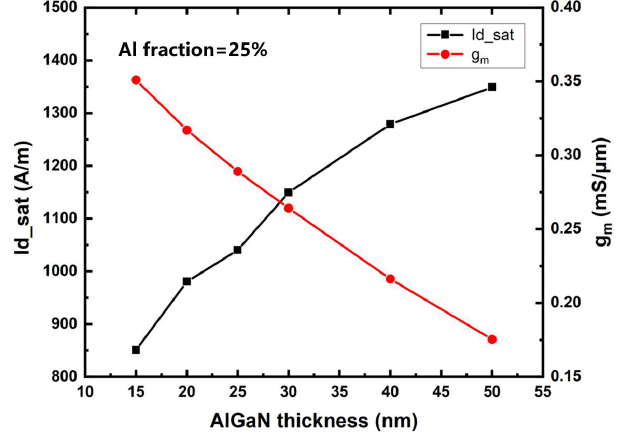
Figure 3. The saturation current density and transconductance of device as barrier layer thickness variation.